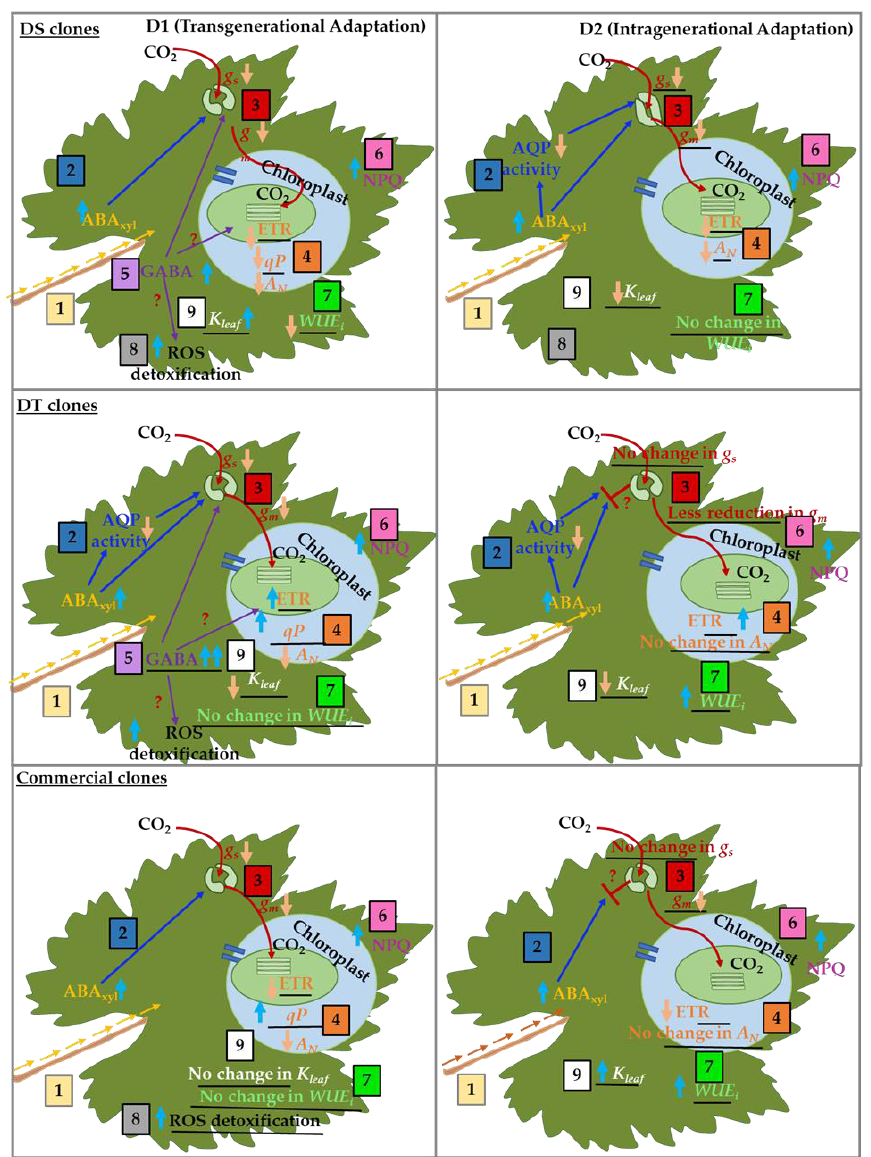
Figure 8. Schematic representation of differential long-term drought acclimation mechanisms of DS (top), DT (middle) and commercial (bottom) clones during first (D1; left) and second (D2; right) drought cycles. The diagram represents (1) accumulation of ABA xyl in the leaf (yellow arrows and letter), (2) ABA-dependent or ABA-AQP-mediated stomatal regulatory mechanisms (blue arrows and letter), (3) CO 2 influx through stomatal and mesophyll conductance (red arrows and letters), (4) photosynthesis-associated processes (orange letters), (5) GABA-mediated priming responses (pur- ple arrows and letters), (6) non-photochemical quenching (pink letters), (7) WUE i (green letters), (8) antioxidative defense responses (black letters) and, (9) leaf hydraulic conductance ( K leaf ; white let- ters). Differential physiological and molecular responses observed between the clones at each drought event have been underlined. Light blue thick arrow indicates an increase or upregulation whereas orange arrow represents a decrease or downregulation. Our findings support a model in which DT clones exhibits a more efficient transgenerational drought acclimation relative to DS clones, possibly through GABA-mediated priming, improved photochemical efficiency, and WUE i at D1. Additionally, improvement in CO 2 influx through stomatal conductance, photochemical